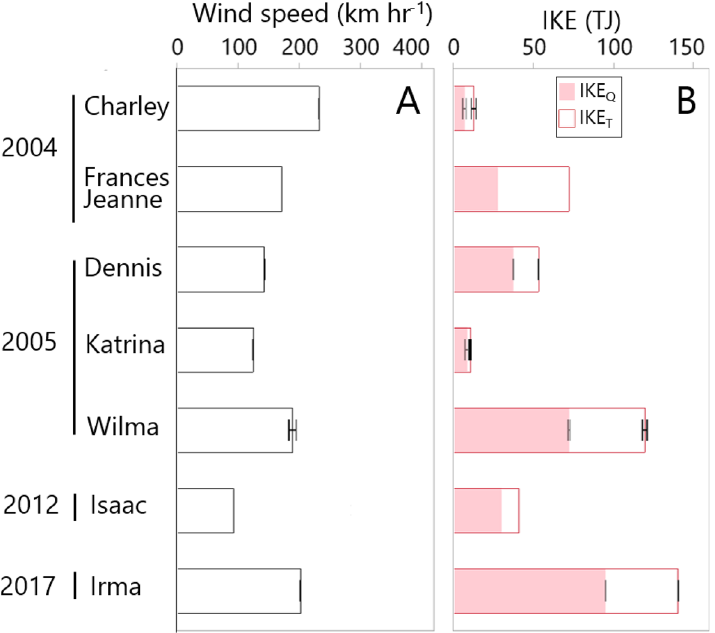
Figure 3. Means (± SE) of ( A) wind speed (km h −1 ) and ( B) Integrated Kinetic Energy (IKE; TJ terajoules) during the timespan when tropical cyclones impacted the Shark River mangrove study sites from 2004 to 2017. IKE Q selected quadrants IKE, IKE T all quadrants IKE; see “Methods” for IKE